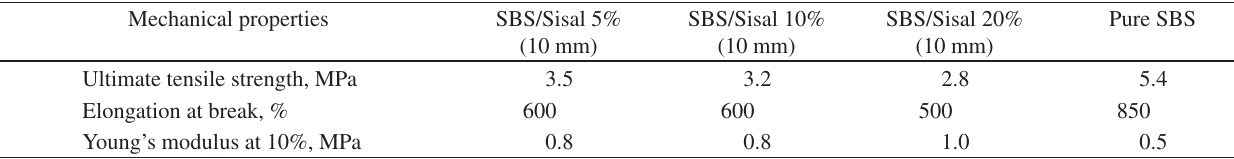
Table 2. Ultimate tensile strength, Elongation at break and Young’s modulus at 10% of SBS/sisal and pure SBS processed in open mixer rolls. Mechanical properties